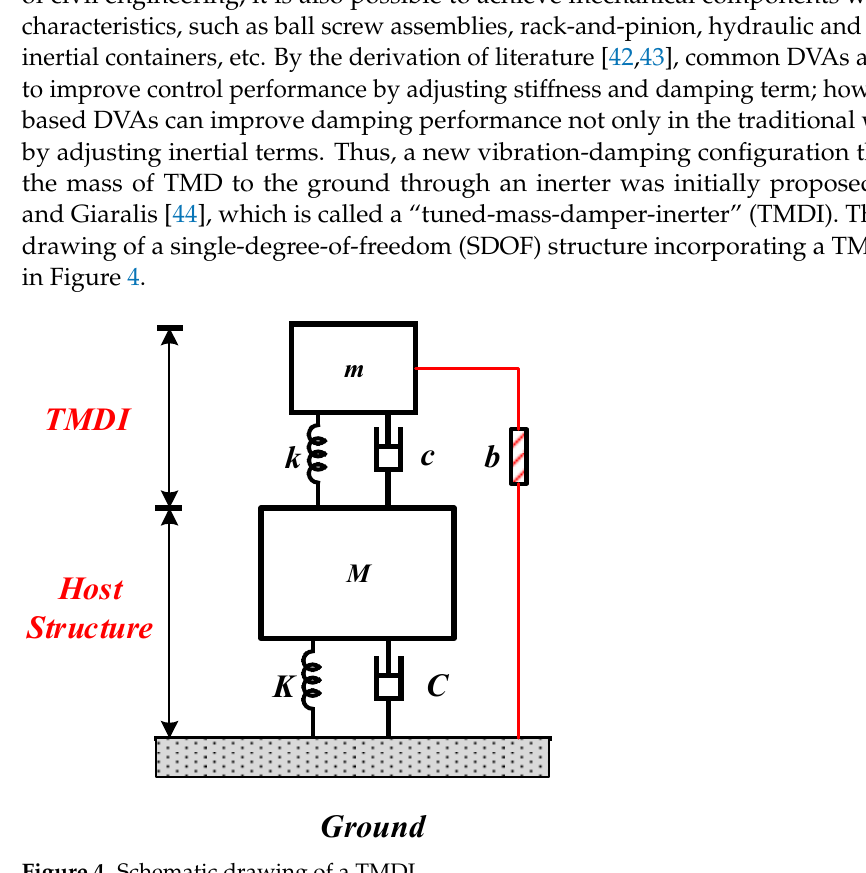
Figure 4. Schematic drawing of a TMDI.